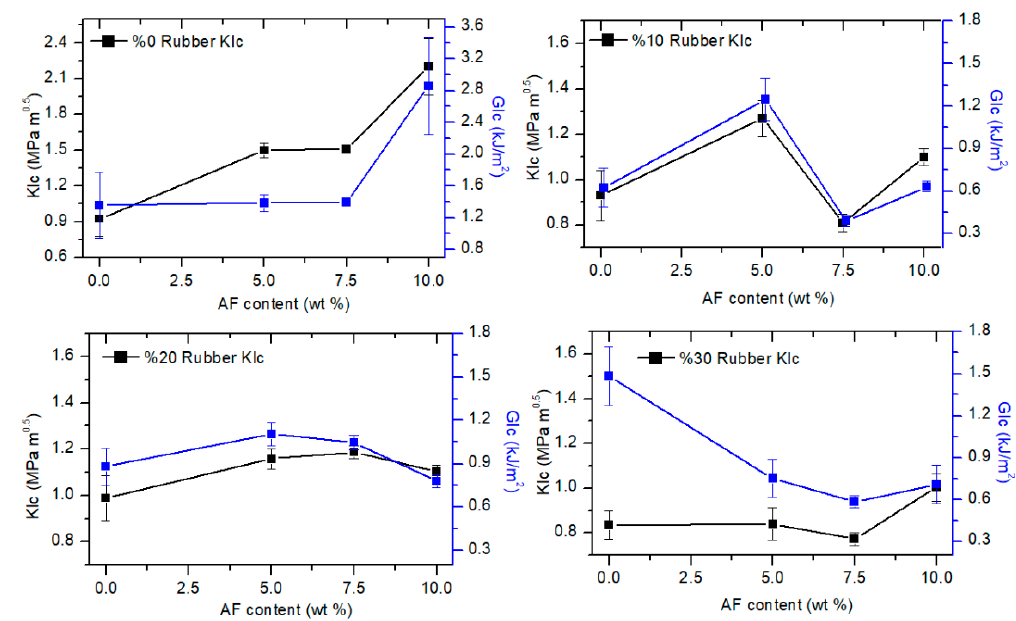
Figure 5. Fracture toughness test results of the manufactured composites.